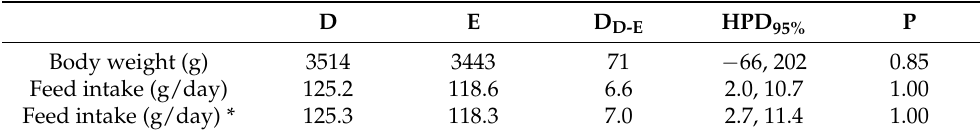
Figure 1. Control and Enriched diet: ( A ) Kaplan–Meier plot. ( B ) Evolution of body weight and feed intake. Table 1. Effect of diet on body weight and feed intake in male rabbits.